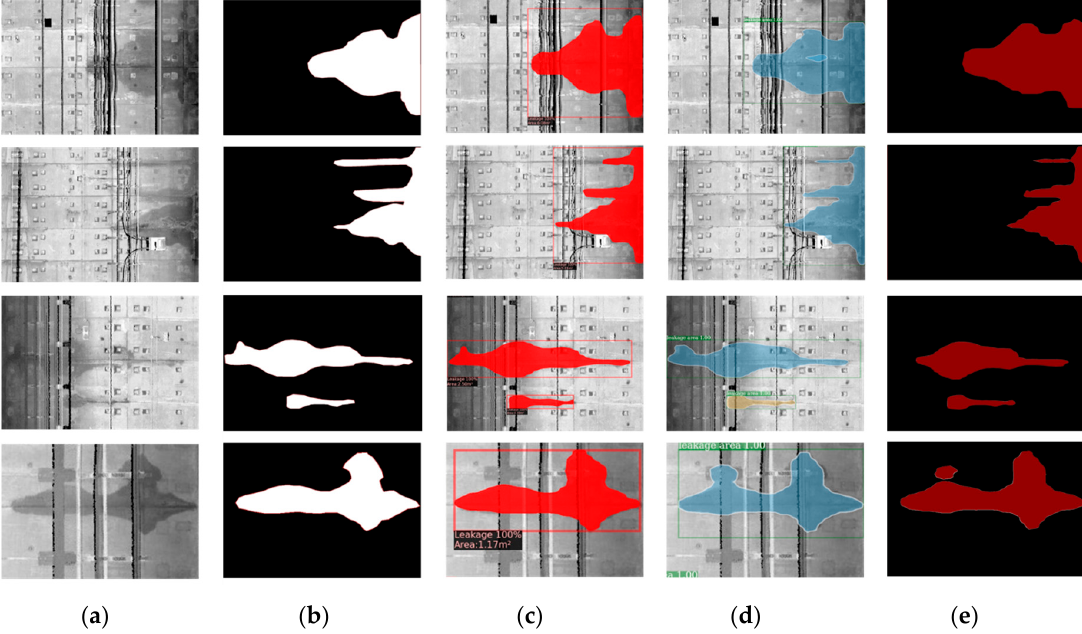
Figure 19. Four testing examples of segmentation results using three different methods. ( a ) Testing images; ( b ) ground truth; ( c ) Mask R-CNN; ( d ) PANet; ( e ) DeepLabV3+.